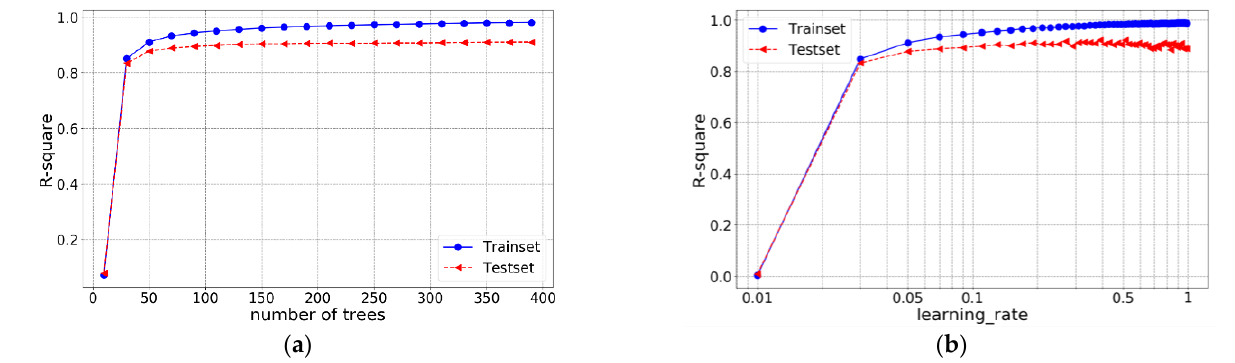
Figure 7. R-square of XGBoost under different hyperparameters: ( a ) different n_estimators; and ( b ) different learning rate.